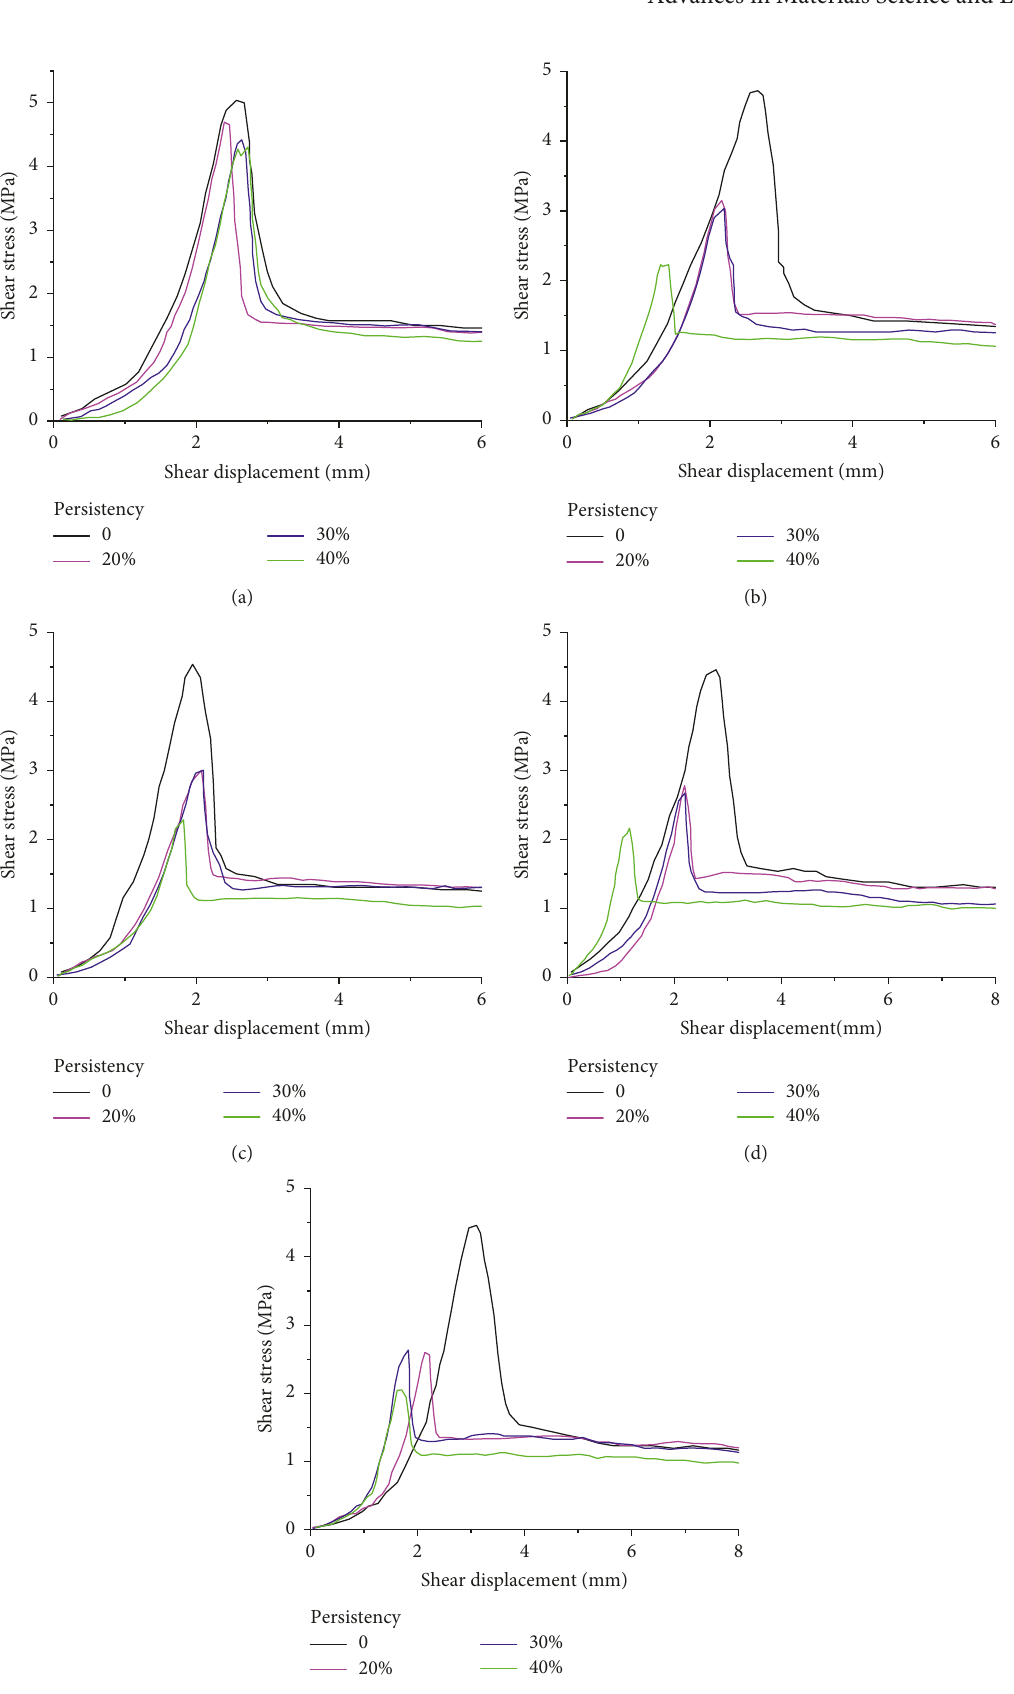
Figure 9: Relationship between shear stress and shear displacement of freezing-thawing specimens with different persistency. Freeze-thaw cycles (a) 0 times, (b) 10 times, (c) 20 times, (d) 30 times, and (e) 40